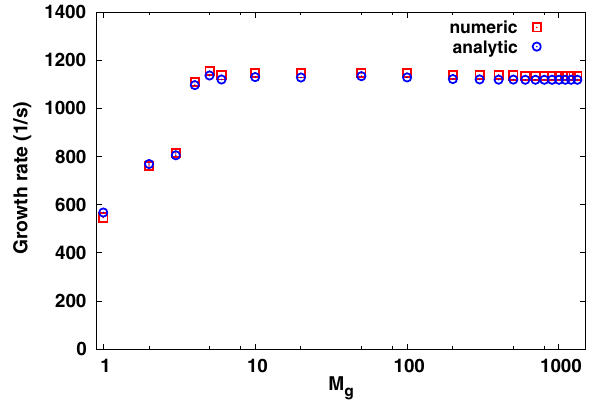
FIG. 6. Comparison of the eigenvalue with the largest imagi- nary part found by solving numerically the eigenvalue problem defined by Eq. (46) as a function of the number of bunches ¼ M − g , with SPACE numerical simulations, showing close M g agreement. Here g is the gap in the uniform filling pattern with M ¼ h ¼ 1320 . The growth rate defined by the eigenvalue with the largest imaginary part is very close to the growth rate of the fastest unstable mode ð 1 = τ Þ U μ ¼ 1119 s − 1 , μ ¼ 1170 of the uni- form filling pattern case over a large range of the gap g